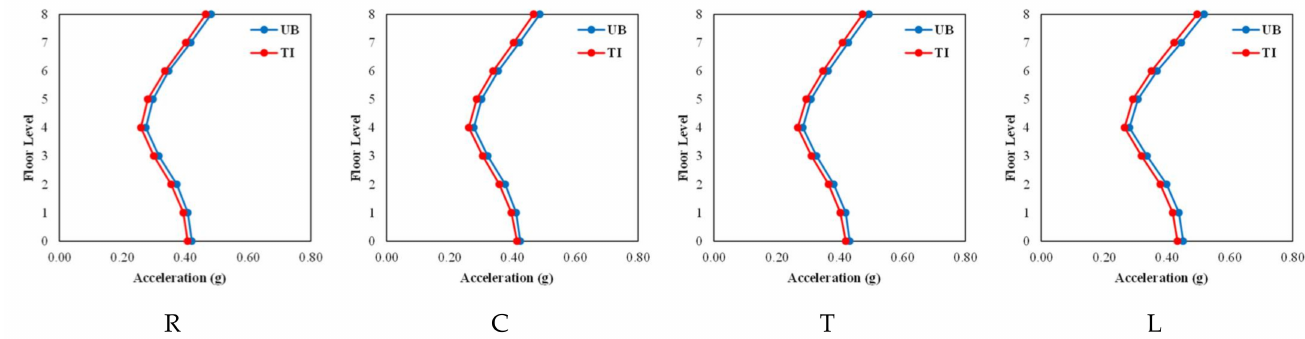
Figure 15. Acceleration for R, C, T, and L models.